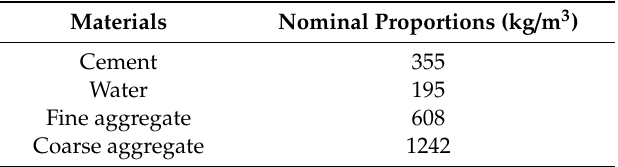
Table 1. Mixture proportions of concrete.